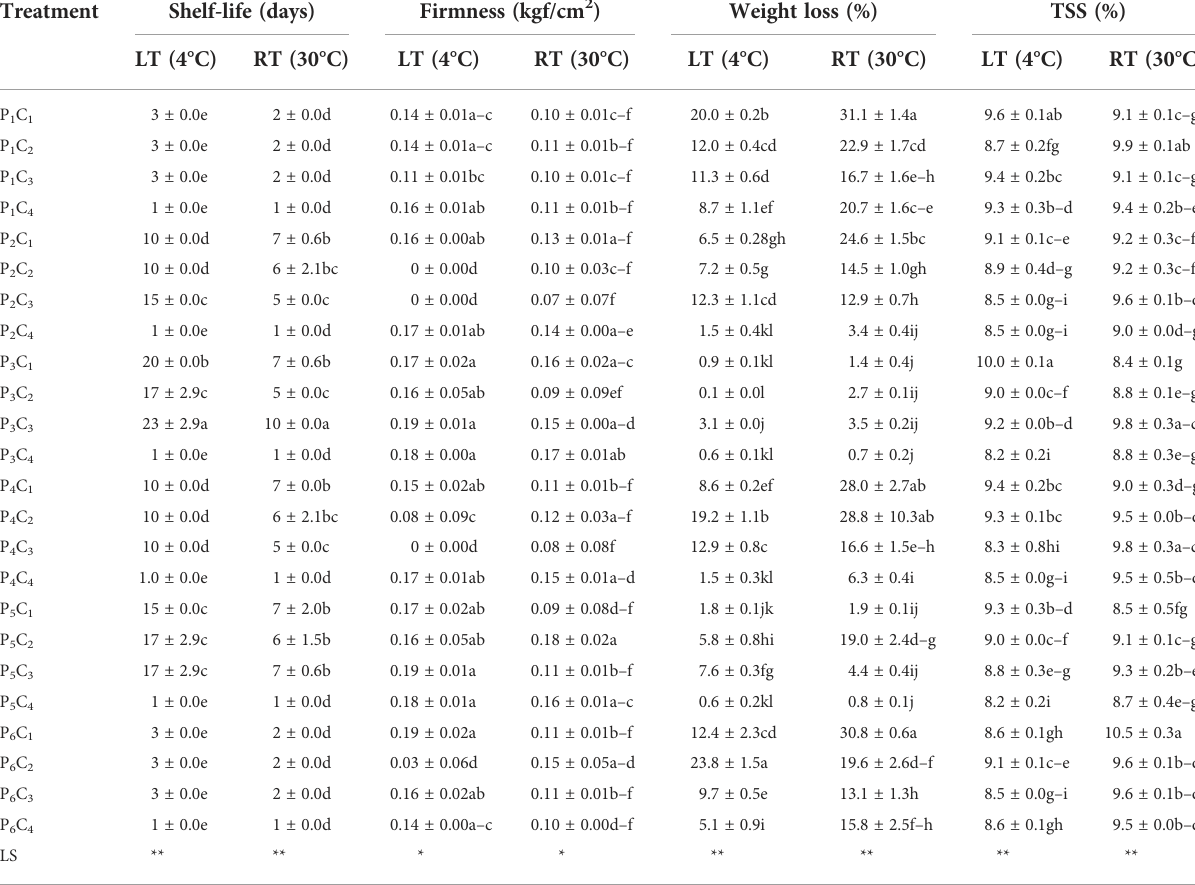
TABLE 1 Physiological attributes of the pointed gourd up to acceptance level under different postharvest treatment and packaging conditions.